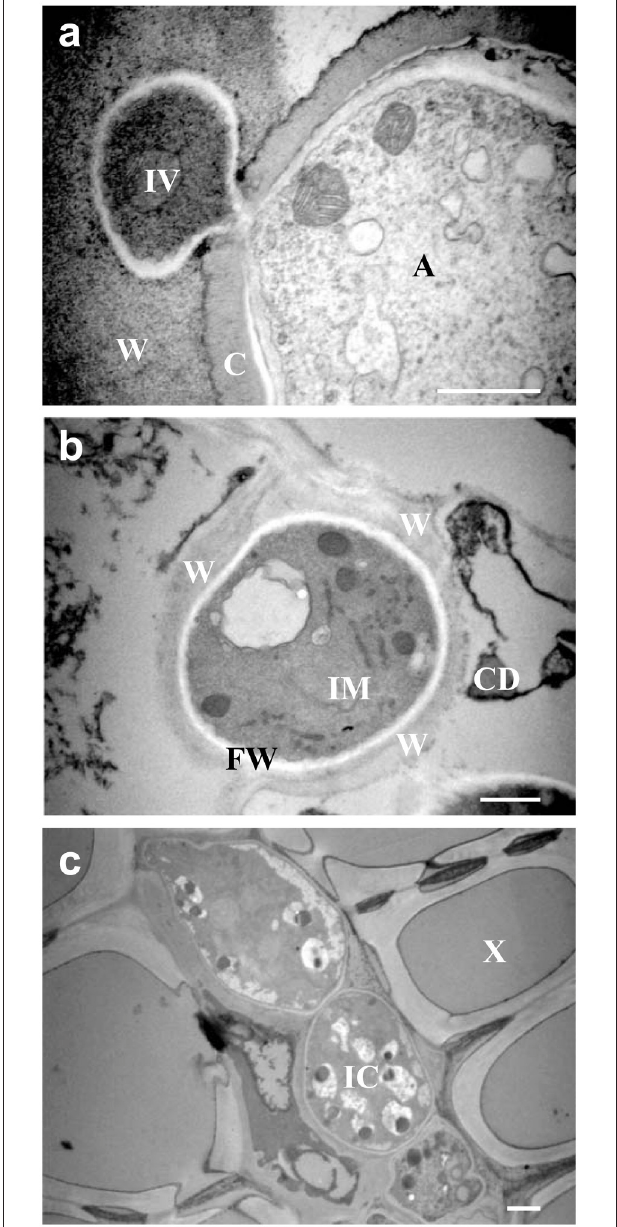
FIGURE 2 | Transmission Electronic Microscopy (TEM) in strawberry crown. (A) Penetration of cuticle and biotrophic stage of C. acutatum by subcuticular hyphae on wall epidermal cell 36 h post-inoculation. (B) Necrotrophic signals of development of C. acutatum by intercellular hypha 4 days post-inoculation. (C) Necrotrophic development of C. acutatum by intracellular hyphae in xylem tissues at 7 dpi. A, appresorium; C, plant cuticle; IV, infection vesicle; W, wall plant cell; IM, intramural o intercellular hypha; FW, fungal cell wall; CD, cell debris; IC, intracellular hyphae; X, xylem. Bar = 1 µ